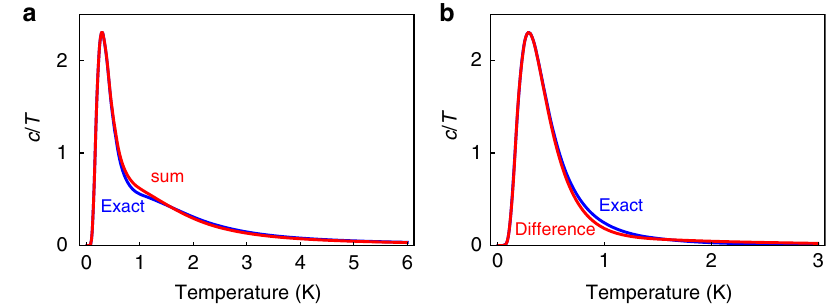
þ ð c = T Þ (red) with the exact value ð c = T Þ SI F